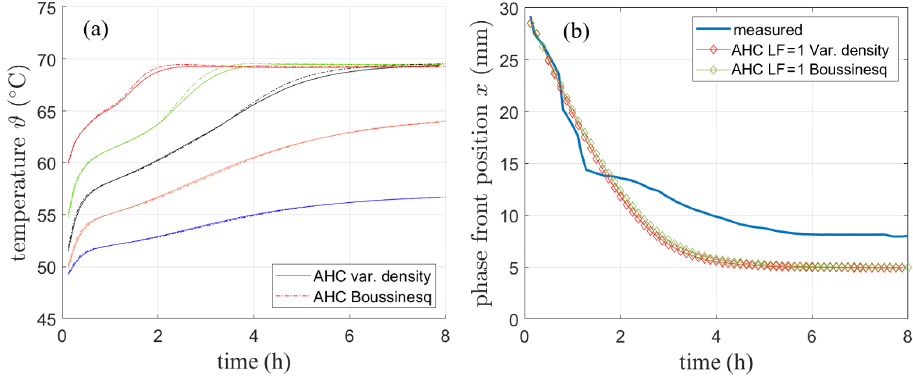
Figure 13. Comparison of AHC model for variable density and Boussinesq approximation regarding ( a ) temperature and ( b ) phase front